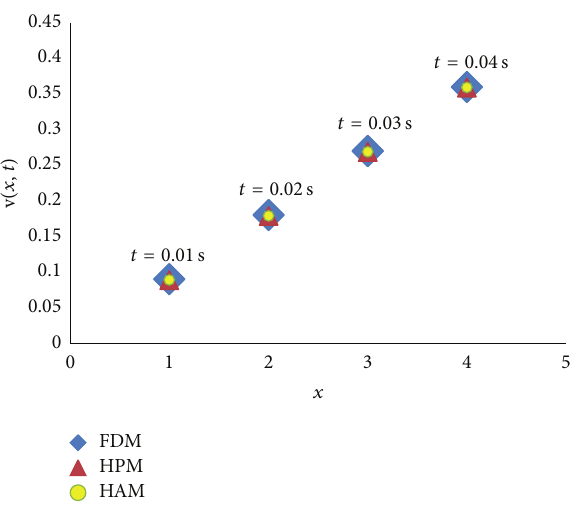
Figure3:ThecomparisonofHPM,HAM,andFDMforthesolution V (𝑥, 𝑡) for different values of 0 ≤ 𝑥 ≥ 8 and 0 ≤ 𝑡 ≥ 0.6 ; ℏ = 0.001 .